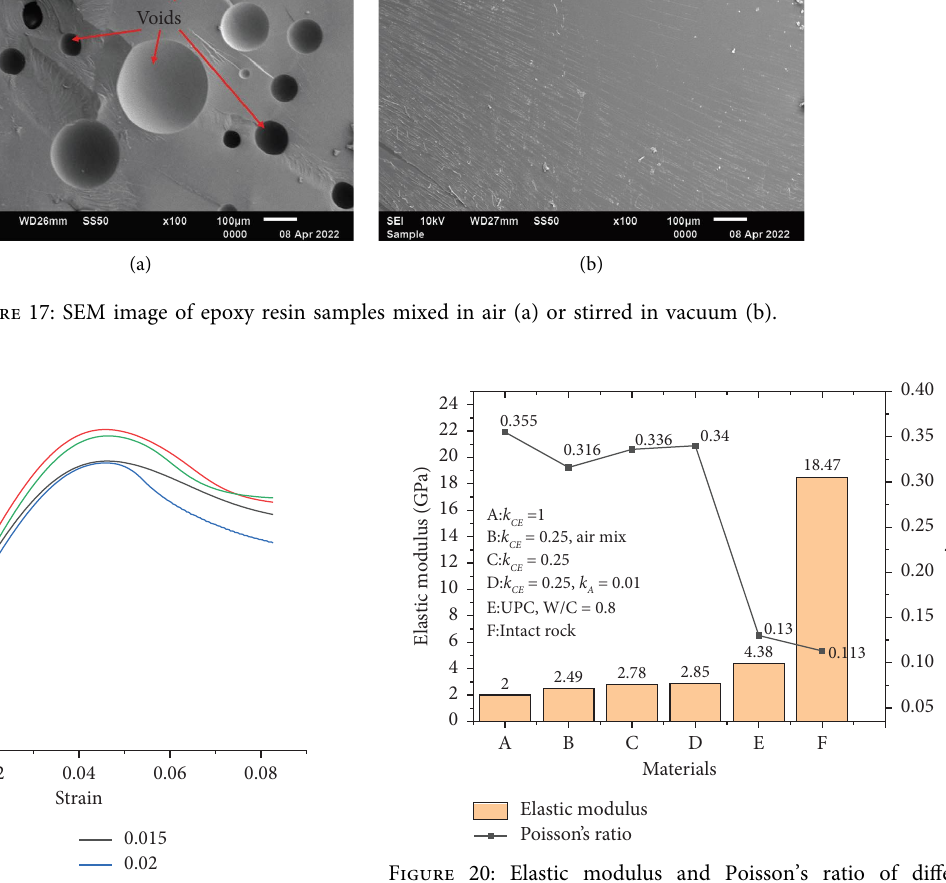
Figure 18: Stress-strain curves with diferent k 0.25.